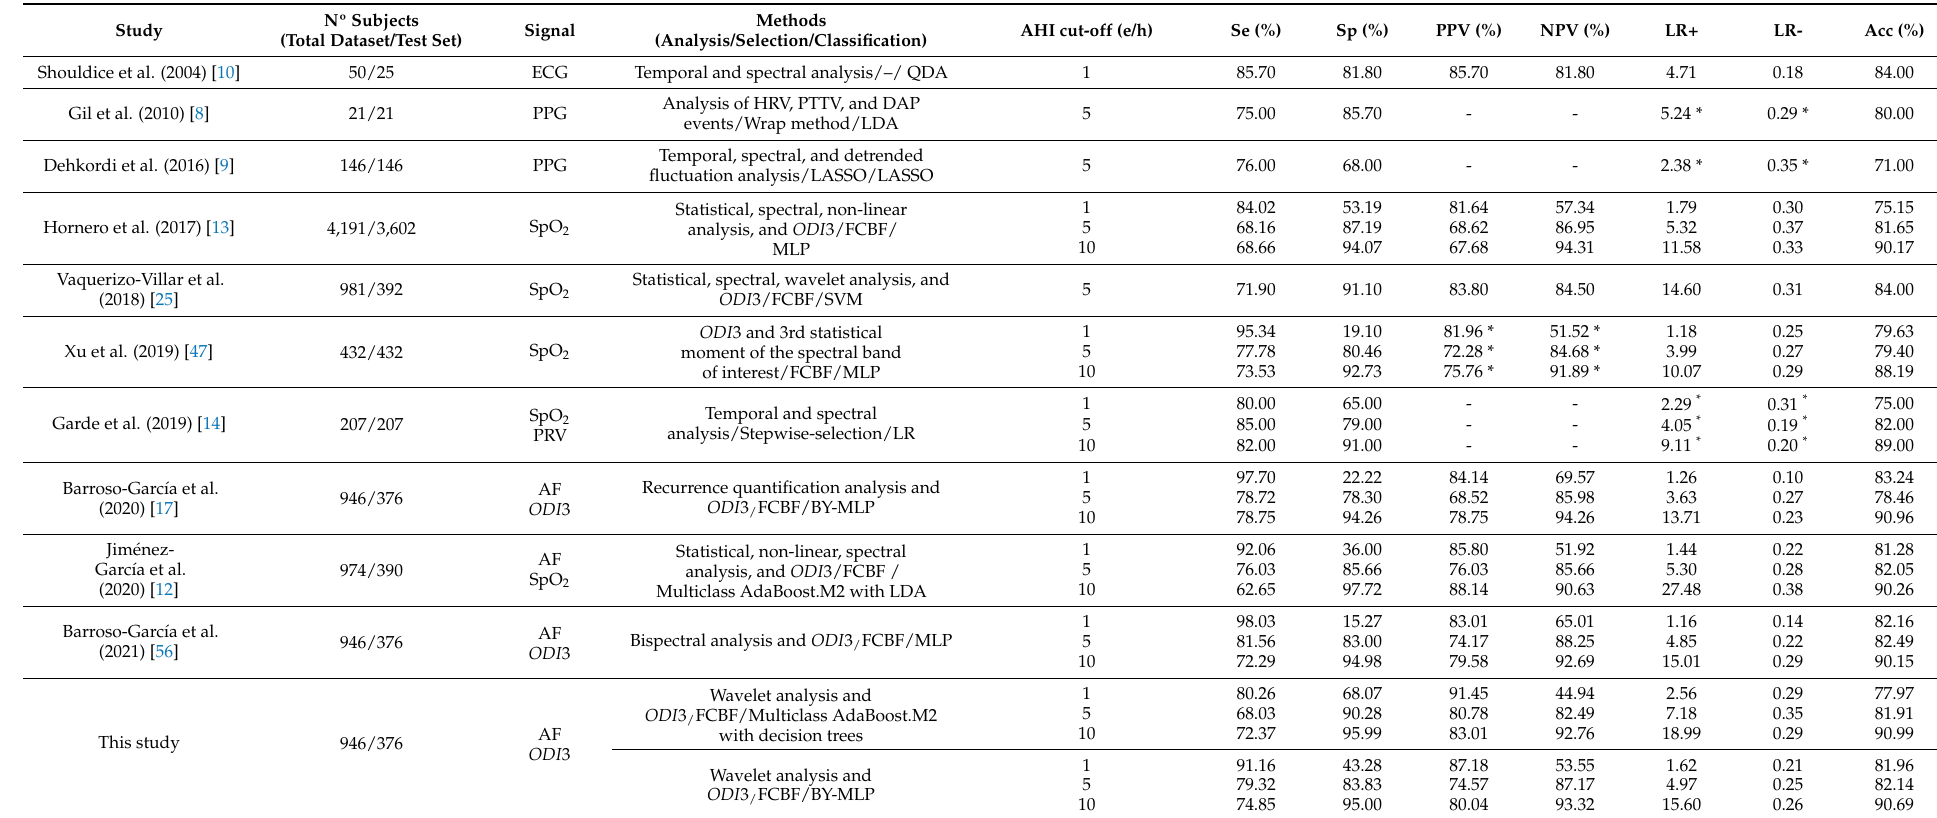
Table 5. Comparison with other studies of the